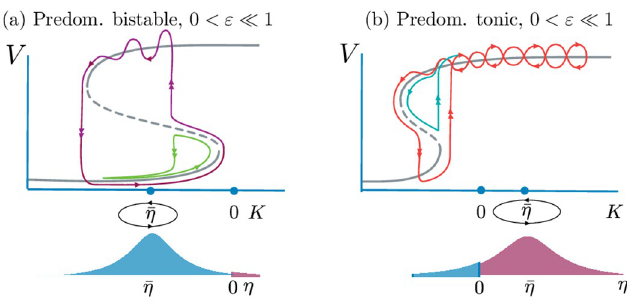
Fig 3. Schematic bifurcation diagram (not to scale, top panels) of the mean-field for the network with randomly- distributed η (bottom panels); some neurons are bistable (blue), and others tonic (red), with distribution centred i at � Z . The ε = 0 equilibria lie on S -shaped curve (grey), whose folds occur for strictly negative values of K . The up state is now a high-voltage, high-rate equilibrium. The geometry of excitability persists when ε � 1, and K ( t ) oscillates slowly around � Z . (a): Down-down and down-up transitions for predominantly bistable distributions ( � Z < 0 ). (b): Up- up and up-down transitions for predominantly tonic distributions ( � Z > 0